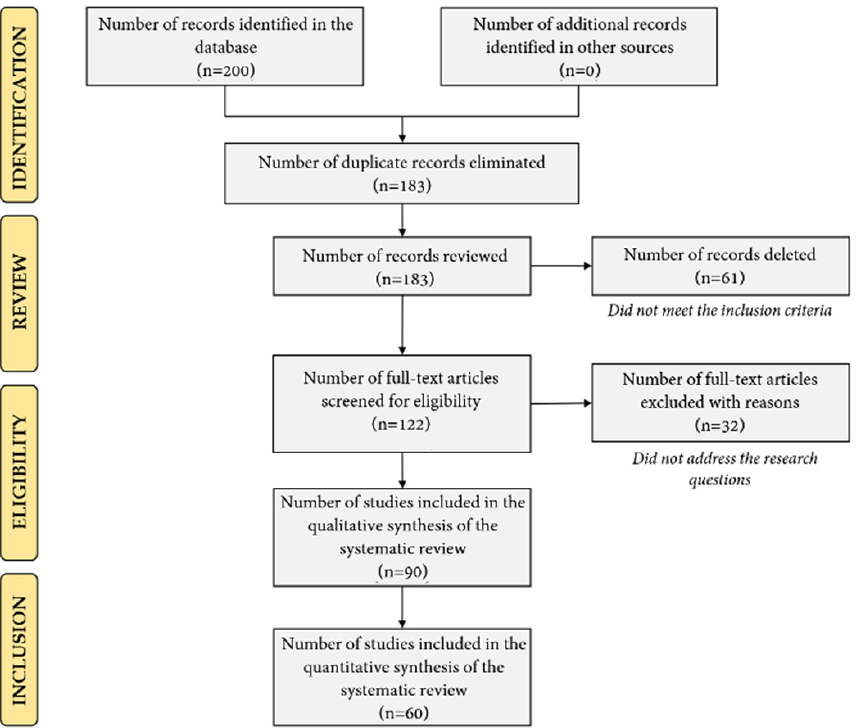
Fig. 2. PRISMA diagram methodology